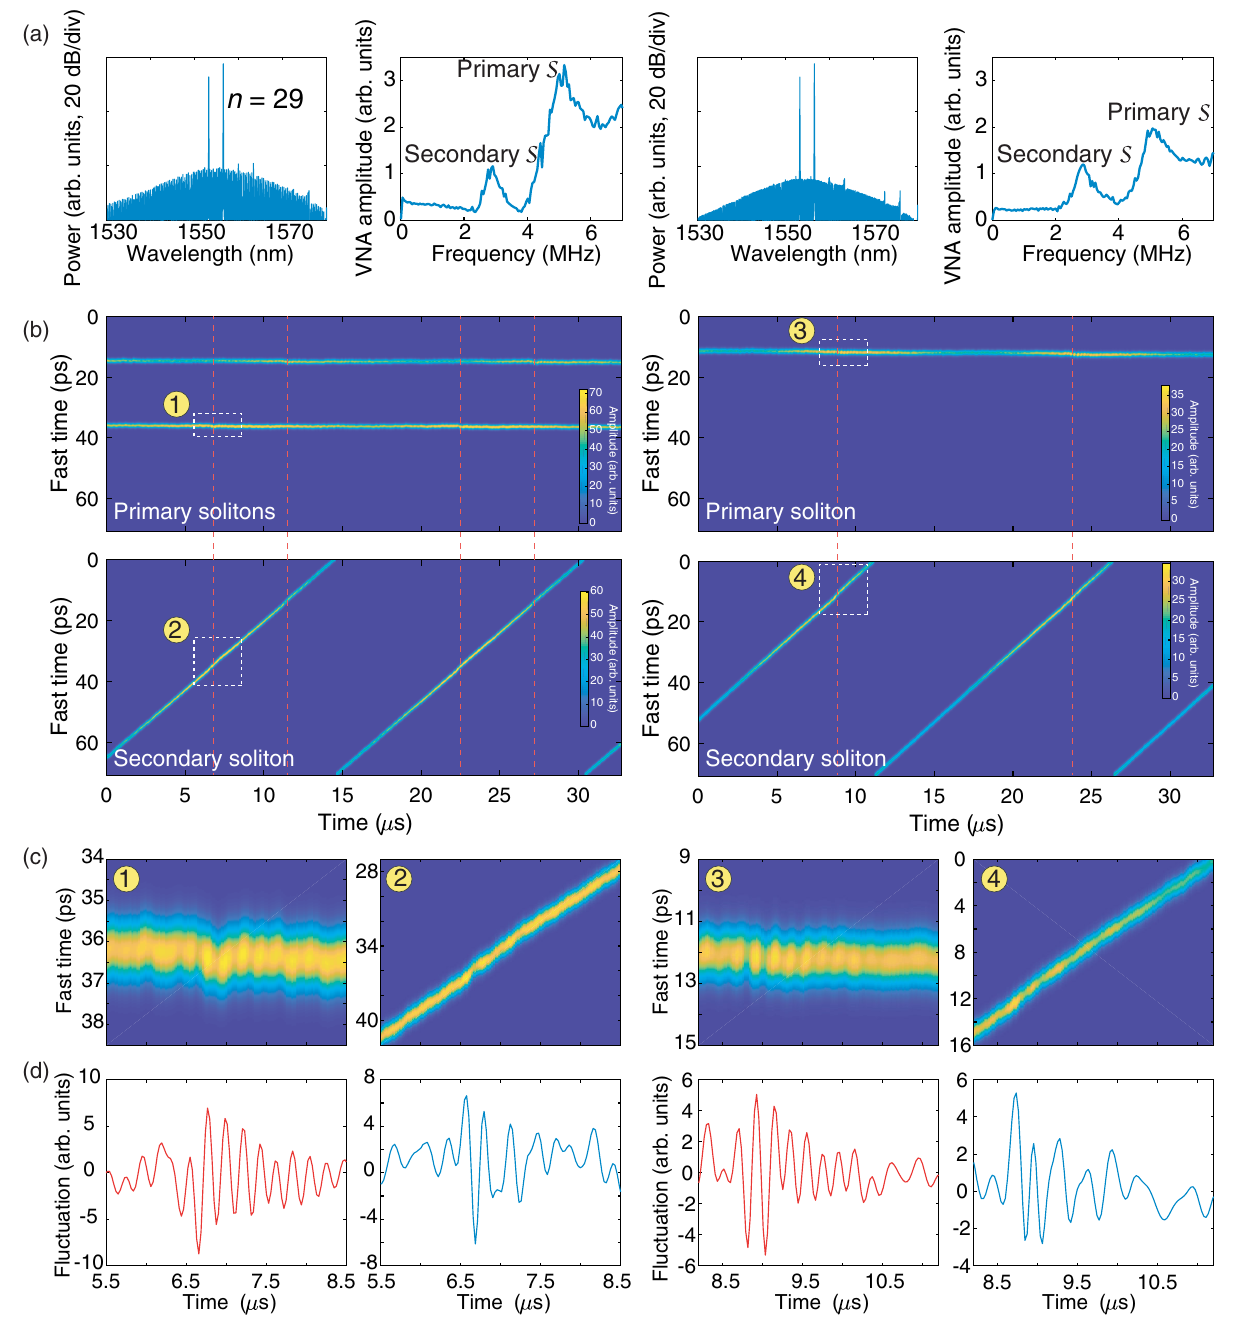
FIG. 5. Imaging of soliton collision dynamics. (a) Optical spectra and VNA response spectra of soliton collision between dual primary solitons and a single secondary soliton (left-hand panel), and between single primary soliton and single secondary soliton (right-hand panel). (b) Images of primary solitons (upper) and secondary solitons (lower) during the soliton collisions. The locations where collisions happen are indicated by the red dashed lines. (c) Enlarged images of soliton collisions. Each corresponds to the numbered white dashed box in (b). (d) The fluctuation of the peak intensities of imaged solitons when collisions occur. The primary soliton and secondary soliton show very different characteristic oscillation